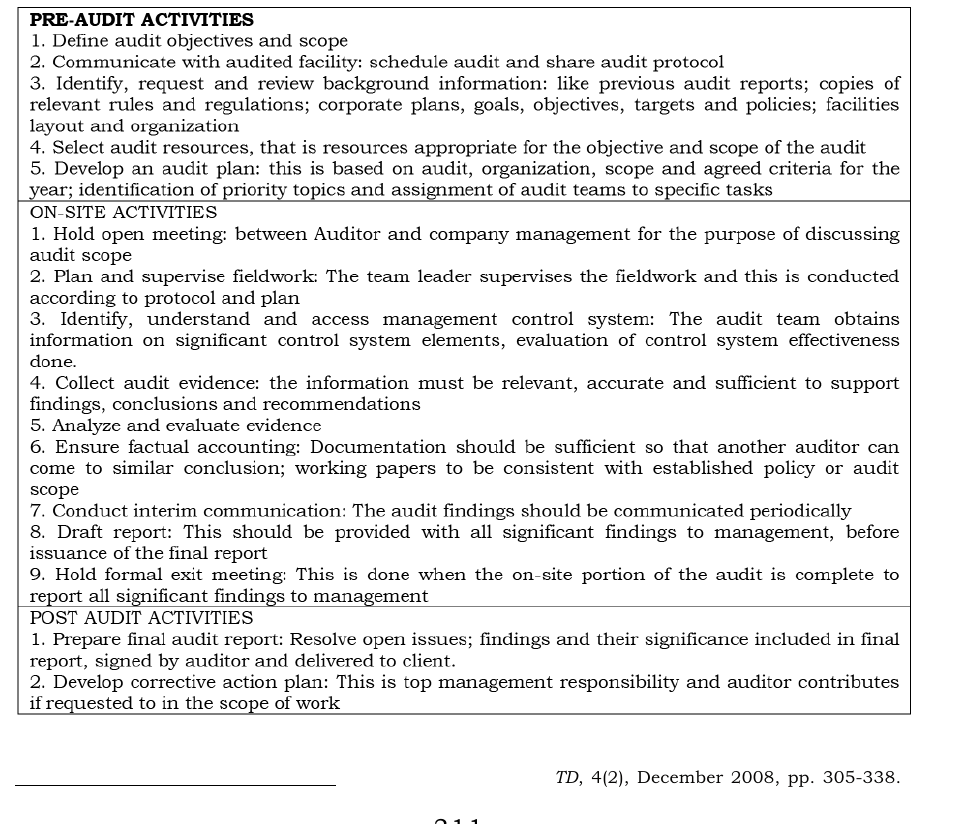
The steps followed in the traditional environmental